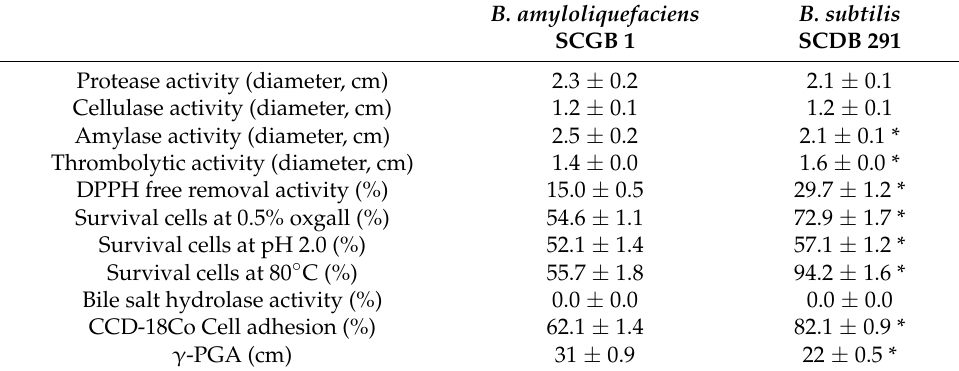
Table 1. The characteristics of two Bacillus spp. used for making chungkookjang, fermented